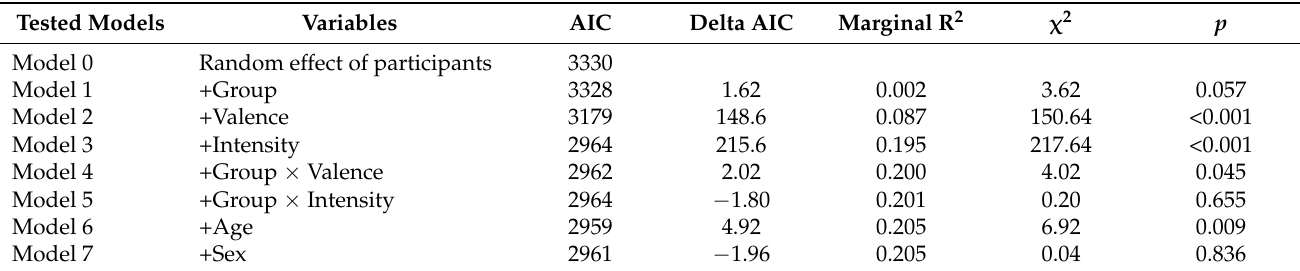
Table 4. Comparison between models predicting accuracy in emotion recognition. Each model includes all the factors of the previous model plus an additional one. Note that smaller values of AIC indicate better fitting models.